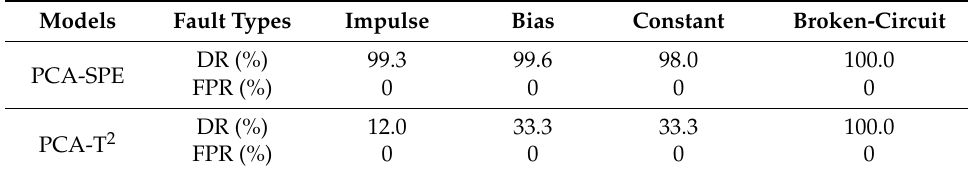
Table 4. DR and FPR of different fault types.